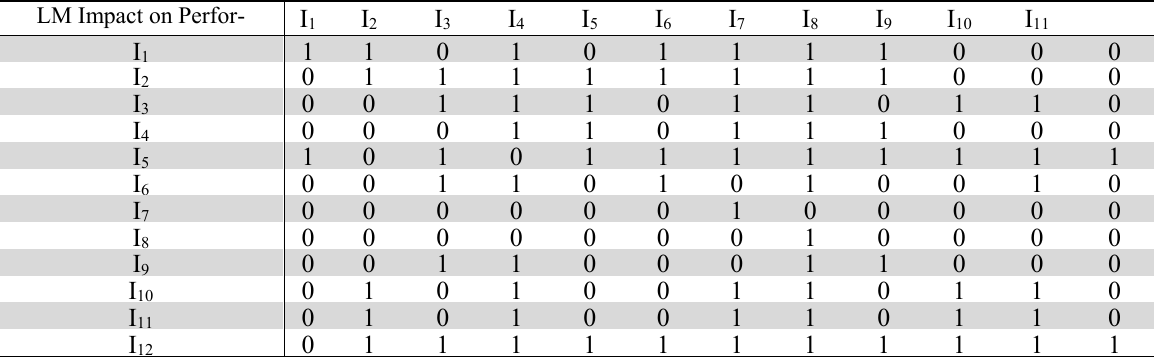
SSIM (Initial Reachability